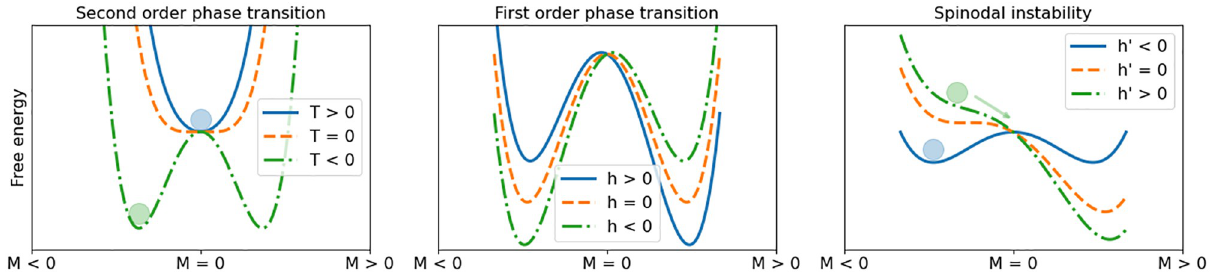
Fig 6. Phase transitions visualized with the Ginzburg-Landau normal form. Left: second-order phase transition triggered by changing temperature at zero external field h . Free-energy undergoes a pitchfork bifurcation from a state with M = 0 to a state with spontaneous, non-zero magnetization. Middle: first-order phase transition, driven by changing the external field h . What could be called transition in this case occurs at the midpoint (orange dashed line) when h = 0 and the free energy of the two global minima equal each-other. No critical transition however occurs. The system remains trapped in a metastable state (blue curve in right image). Right: spinodal instability. Here, the transitions happens when the derivative of h in the left attractor basin becomes zero, that is, when the left local minimum disappears and the metastable state loses stability. The system finally shifts to the lowest free-energy state. The actual CT